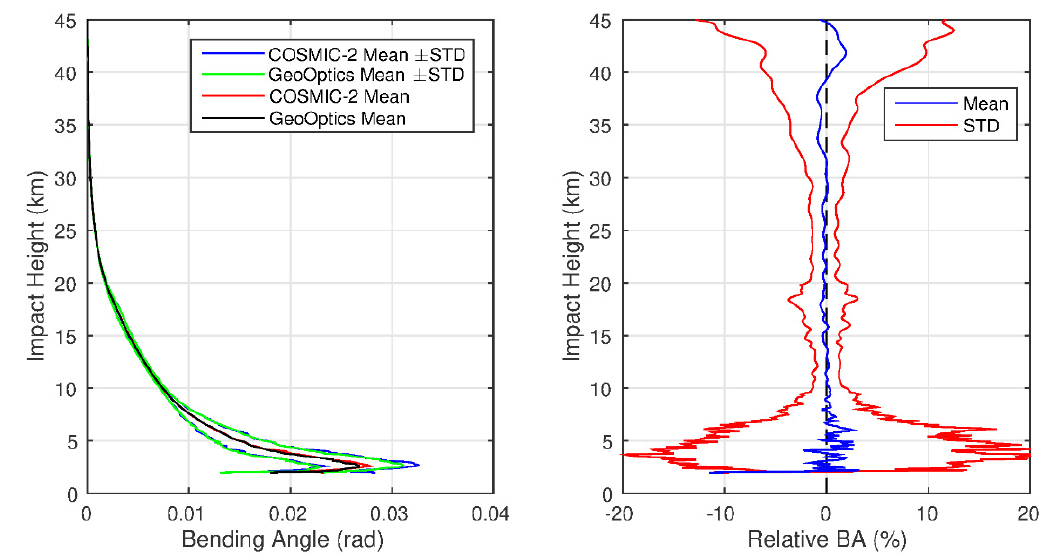
Figure 14. This figure is the same as Figure 13, but for GLONASS satellites over a total of 107 SRO cases.